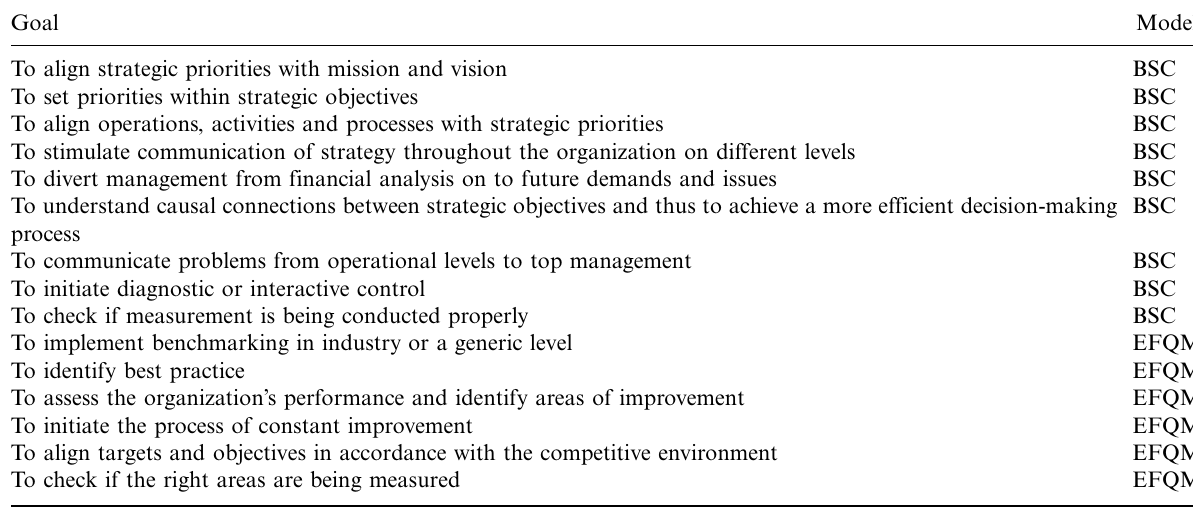
Table 1. Selecting the most appropriate model for different management requirements Goal